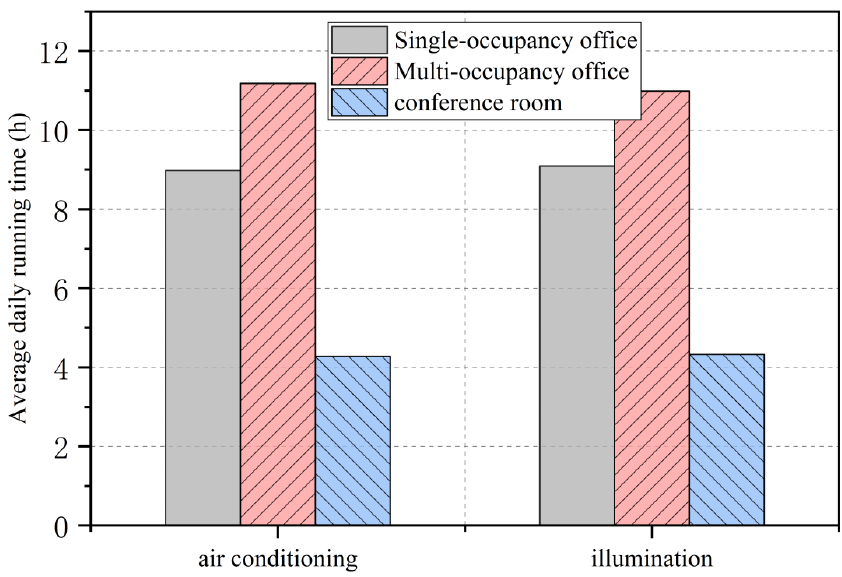
Figure 19. Effects of the type of office space on the running hours of air conditioning.